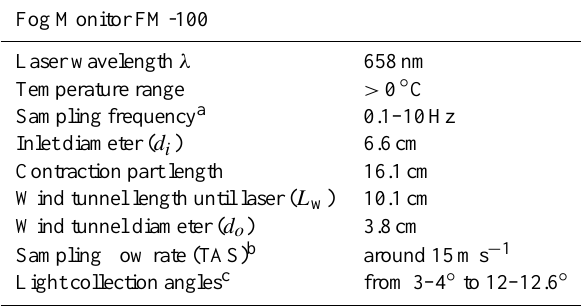
Table 1. Technical specifications of the FM-100 taken from Droplet Measurement Technologies